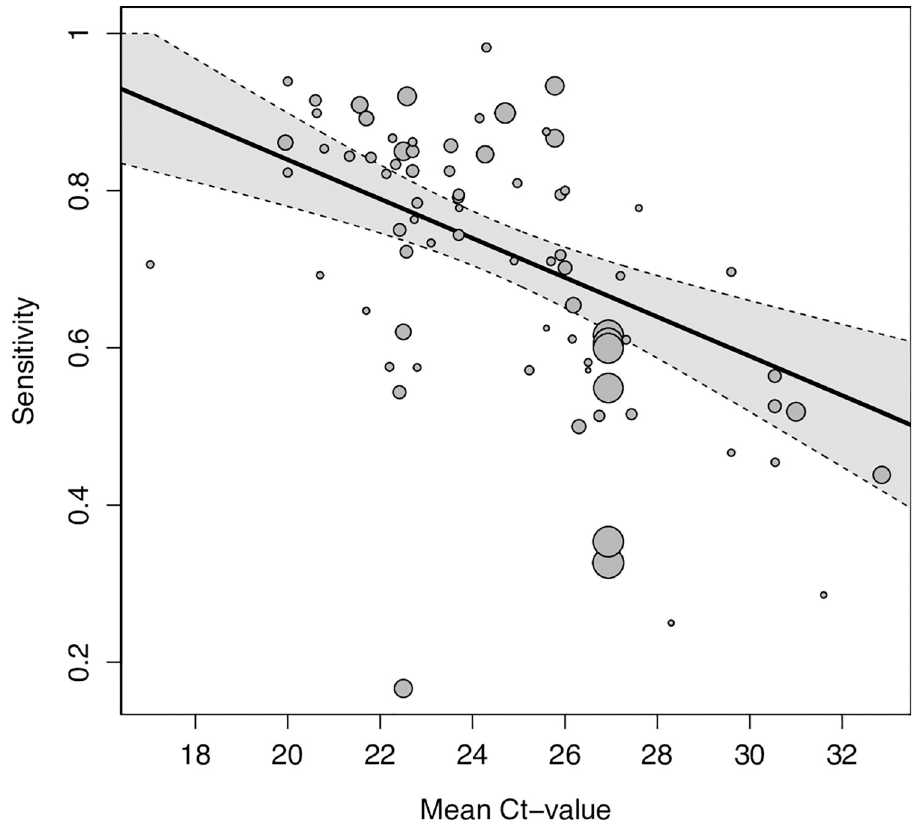
Fig 4. Pooled estimate of sensitivity across mean Ct-values holding symptom status and IFU-status constant at their respective means. Dotted lines are the corresponding 95% CIs. The size of each point is a function of the weight of the data set in the model, where larger data sets have larger points. CI, confidence interval; Ct, cycle threshold; IFU, instructions for use.